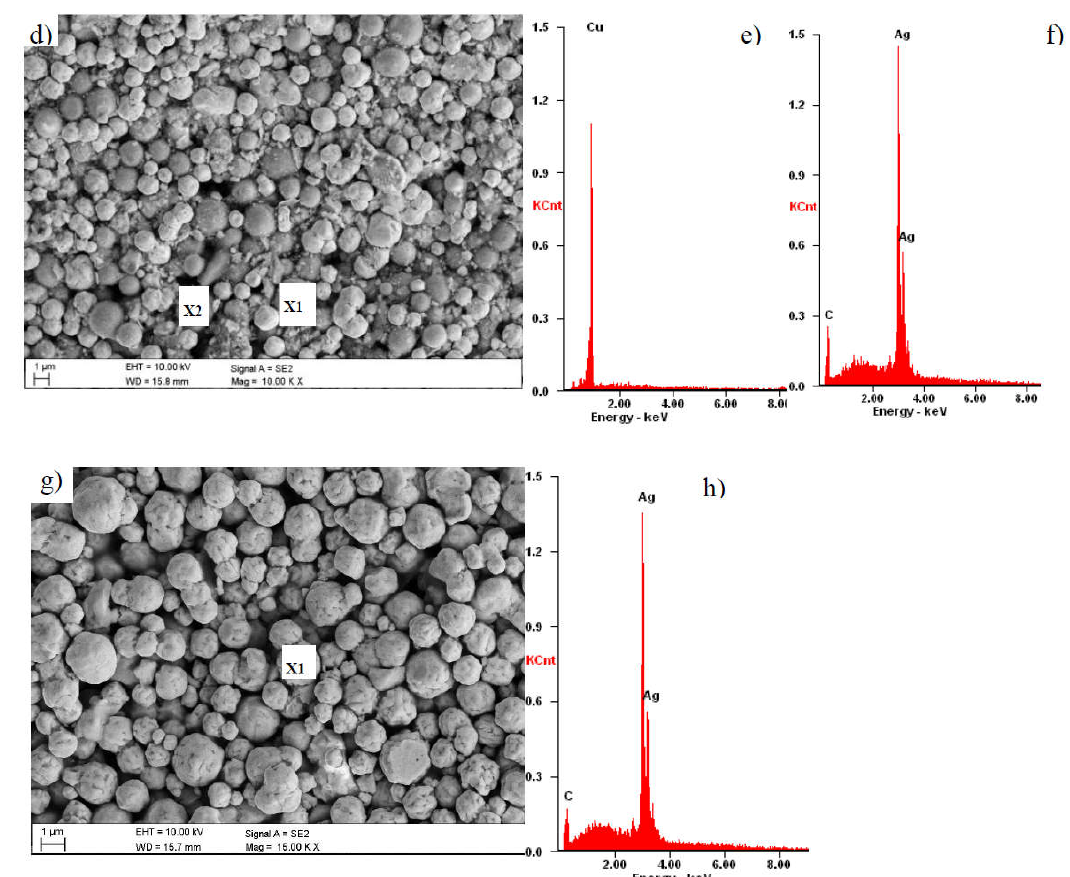
Figure 6. SEM micrograph presenting experimental NPCuXX pastes: ( a ) A, ( d ) B and commercial, and ( g ) REF (reference) paste, and plot of energy dispersion X-rays shown in ( b – h ) from micro-areas in insets from ( a – g ), where X1 and X2 are micro-areas which were performed energy dispersive spectroscopy investigations.